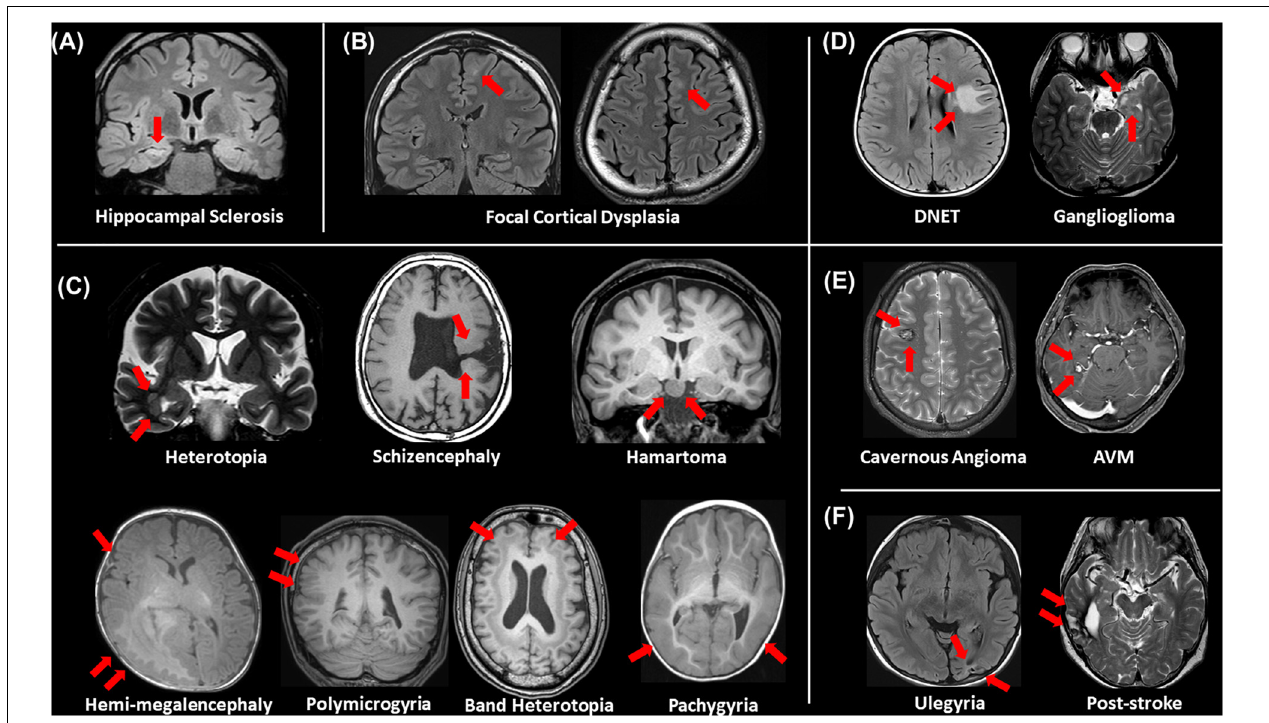
FIGURE 1 | An overview of visible epileptogenic lesions (red arrows). (A) Hippocampal sclerosis, (B) focal cortical dysplasia, (C) other malformations of cortical development, (D) neoplasms, (E) vascular malformations, and (F) cerebrovascular lesions.